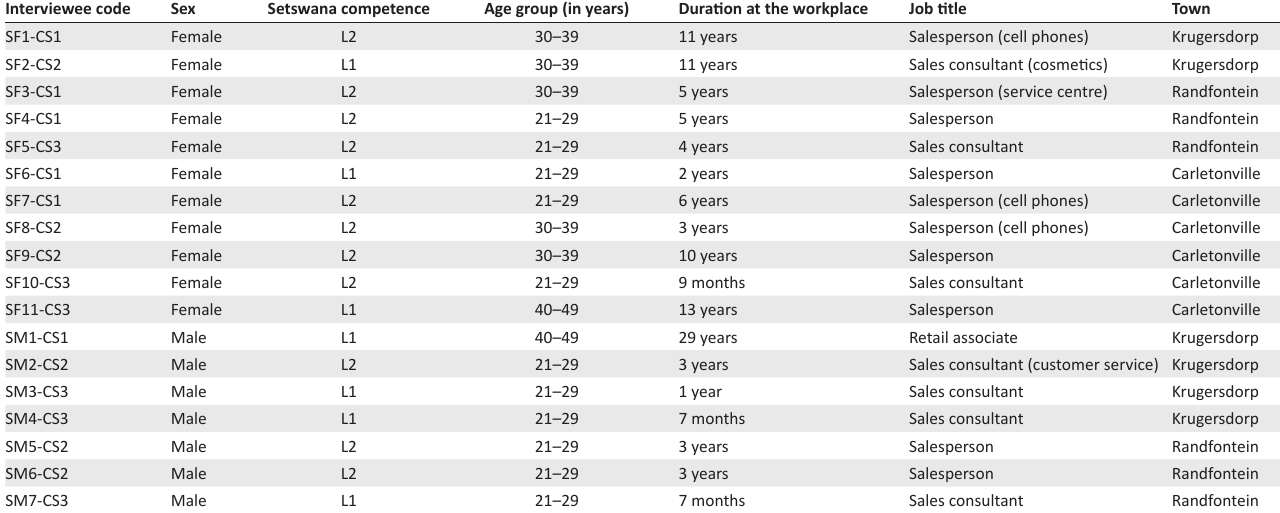
TABLE 1-A2: Salespersons’ biographic